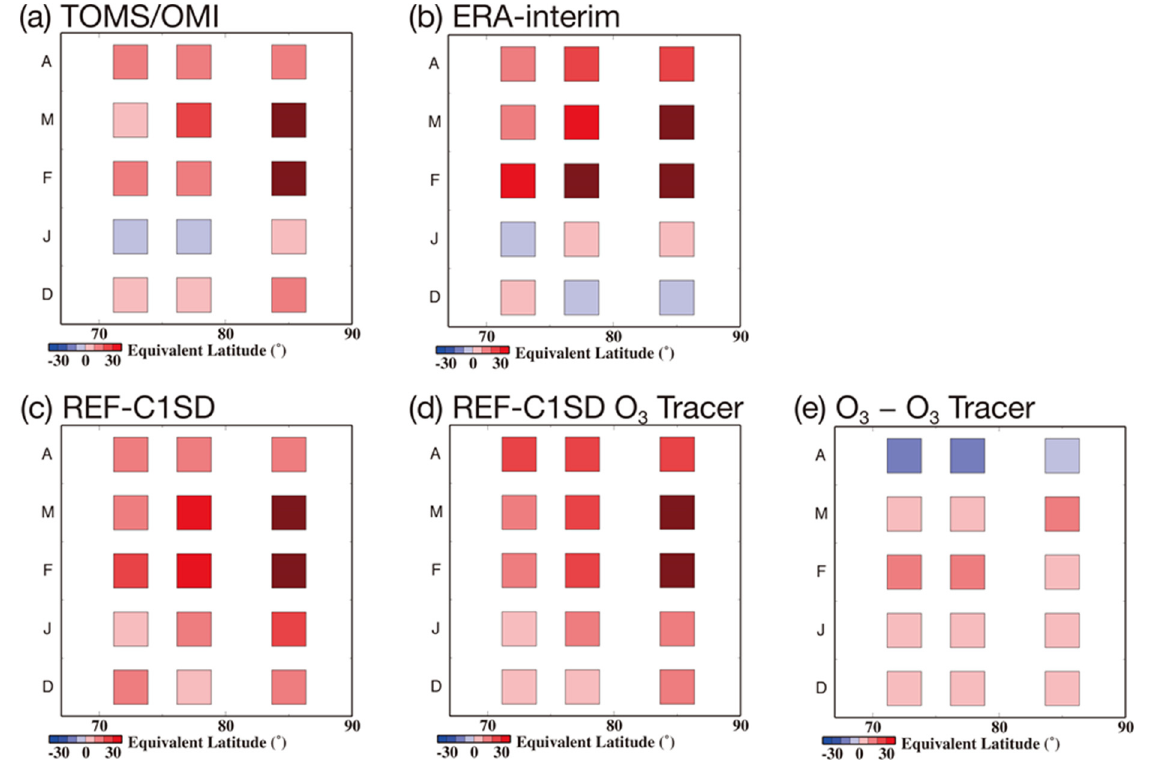
Figure 11. Same as Figure 7 but for the anomalies in 2009 (December 2008–April